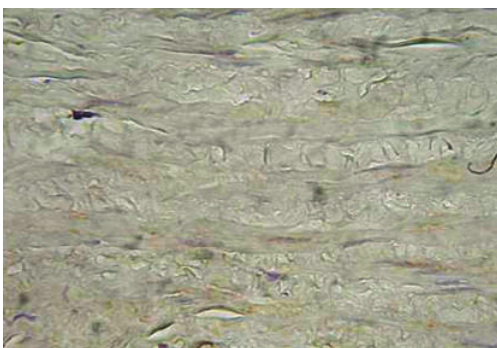
Figure 4: Expression of eNOS in the tunica media of varicose vein (magnification 400x, DAB).